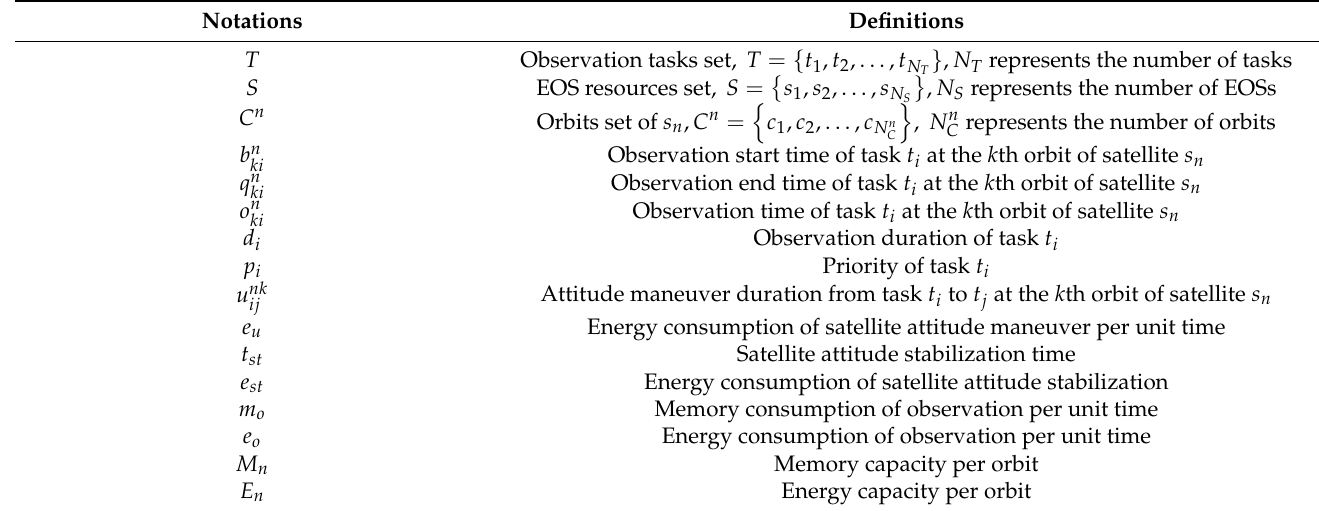
Table 1. Definitions of the problem’s